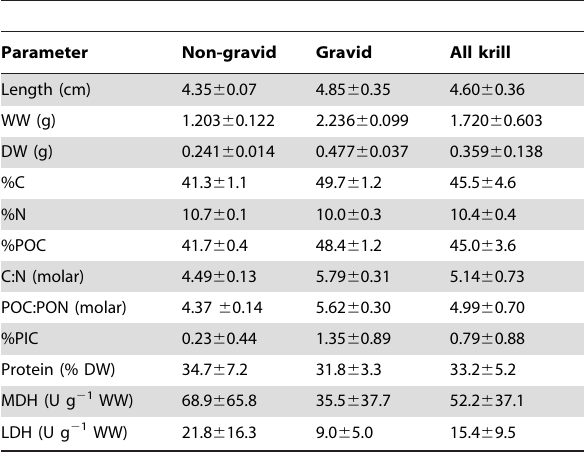
Table 3. Physical and chemical characteristics of Euphausia superba